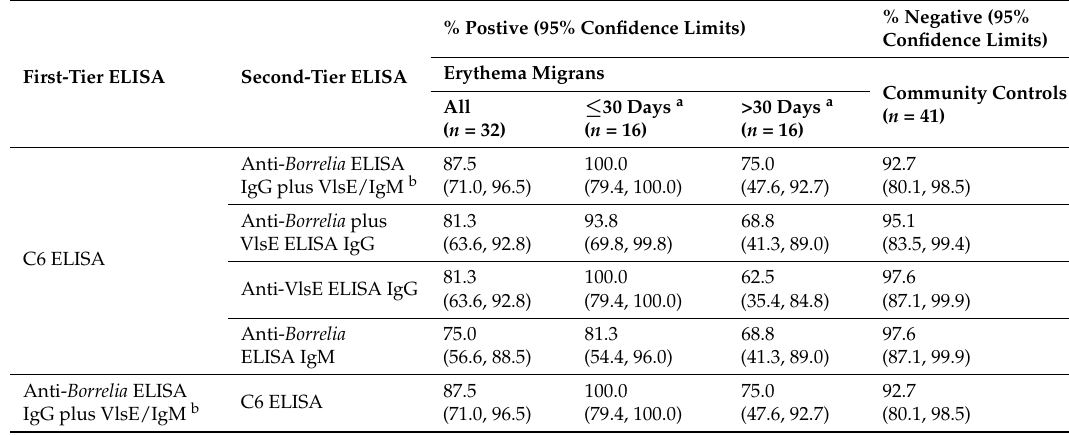
Table 6. Prevalence of anti- Borrelia antibodies by two-tiered testing (ELISA–ELISA) among patients with erythema